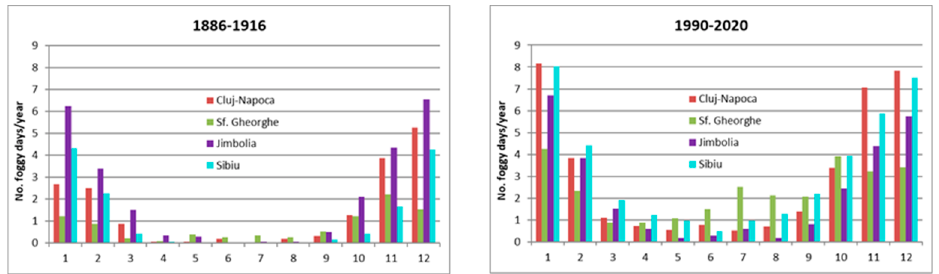
Figure 4. The monthly distribution of fog events over the Transylvania Region in the periods of 1886–1916 and 1990–2020.